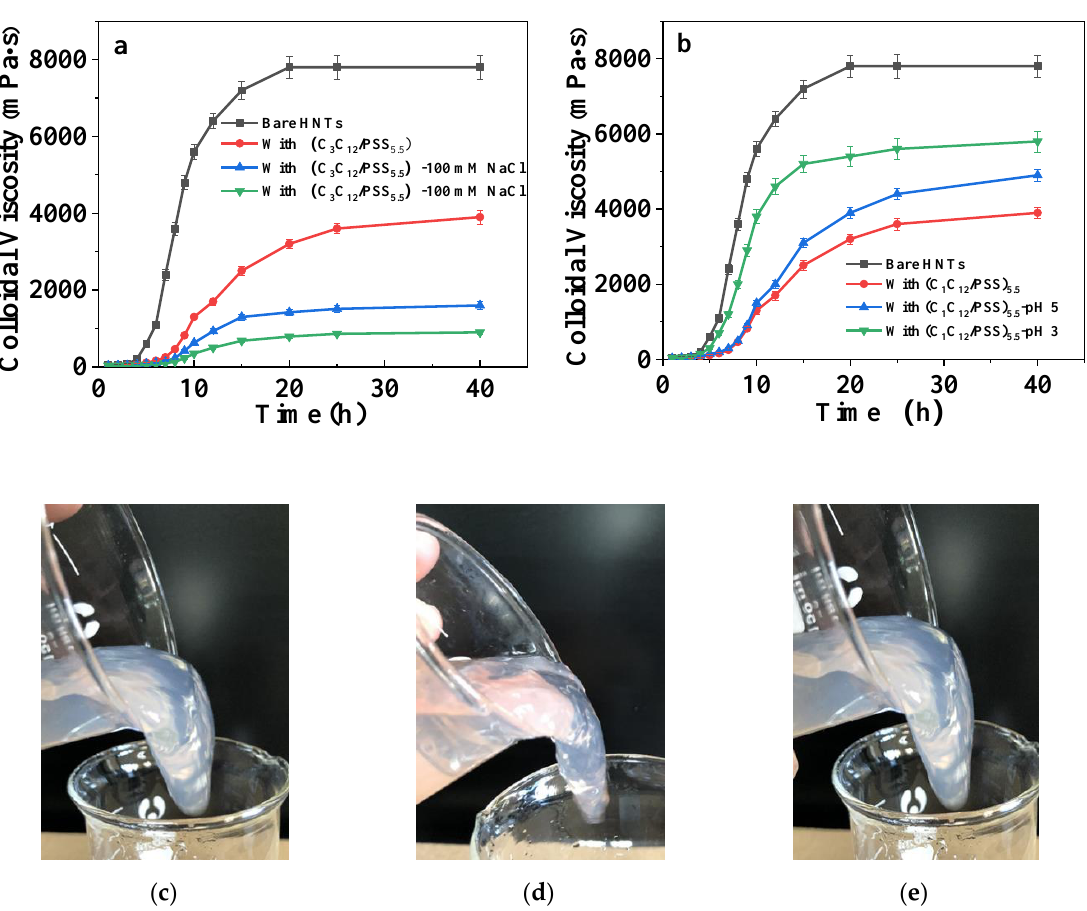
Figure 5. The colloidal viscosity–time profiles of polyacryamide solutions under different conditions: ( a ) in the presence of NaCl at different concentrations and HNTs@(G 3 C 12 /PSS) 5.5 ; ( b ) under different pH values and in the presence of HNTs@(G 1 C 12 /PSS) 5.5 ; ( c ) PAM gel without HNTs; ( d ) PAM gel in the presence of NaCl at different concentrations in HNTs@(G 3 C 12 /PSS) 5.5 systems; ( e ) PAM gel at pH